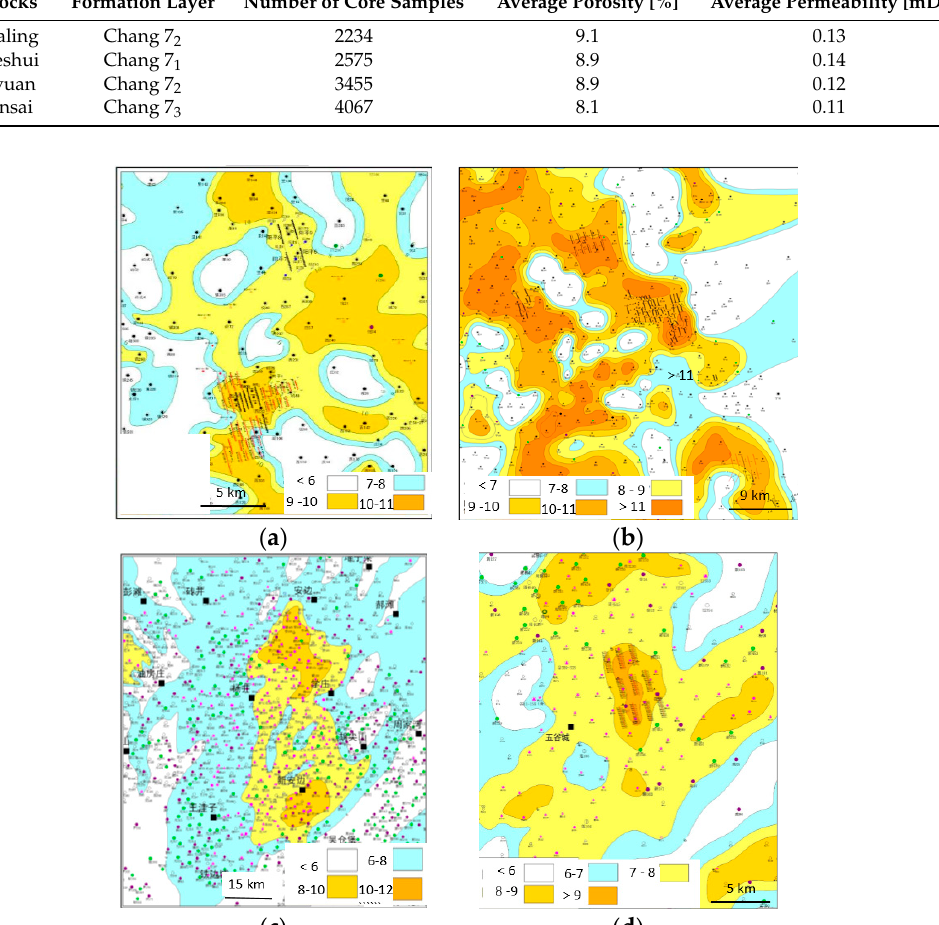
Figure 6. Porosity (%) distributions of the four pilot areas in Chang 7: ( a ) Maling, ( b ) Heshui, ( c ) Jiyuan, ( d ) Ansai.